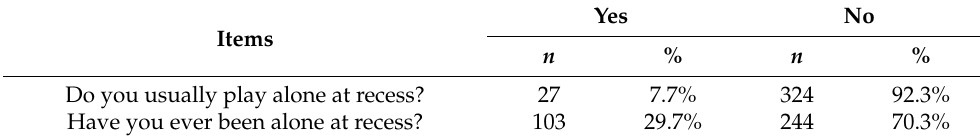
Table 4. Children’s social interactions in primary school in the pandemic—playing alone.